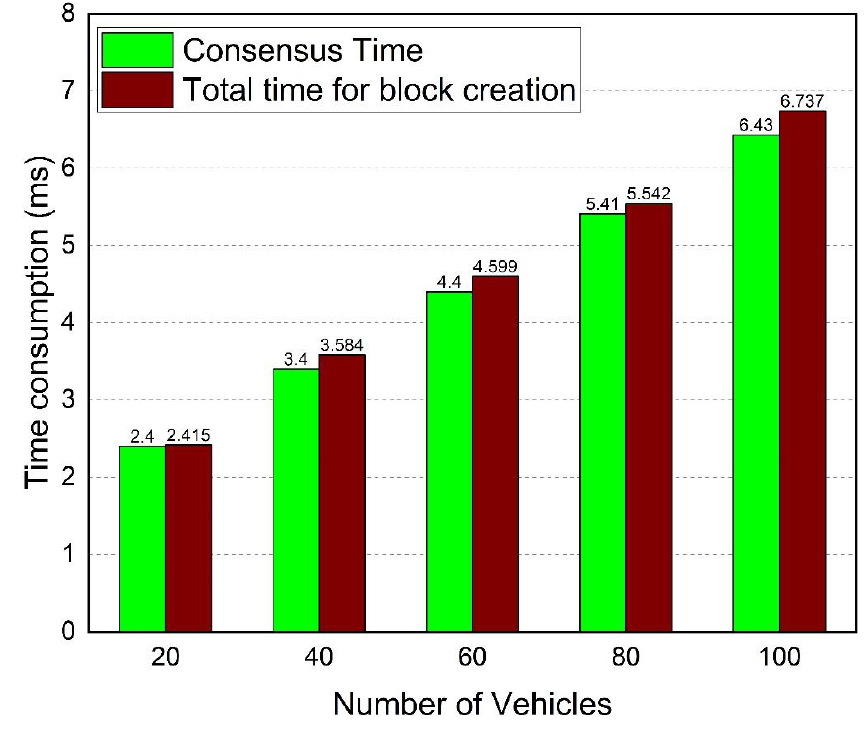
Figure 13. The time taken for block creation and consensus.